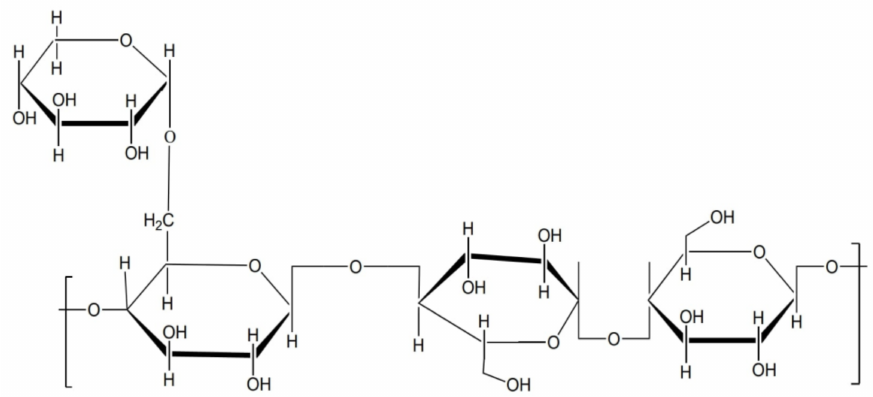
Figure 1. Chemical structure of tamarind seed polymer. Gums, also known as polysaccharides, are water-soluble complex carbohydrates that may be used to make gels and mucilages. Galactose, arabinose, rhamnose, xylose, and galacturonic acid are only a few of the sugars that may be used to make them [7]. They have gelling, thickening, moisture retention, emulsification, and stabilizing properties. Polysac- charides are frequently utilized in food product manufacturing due to their versatility